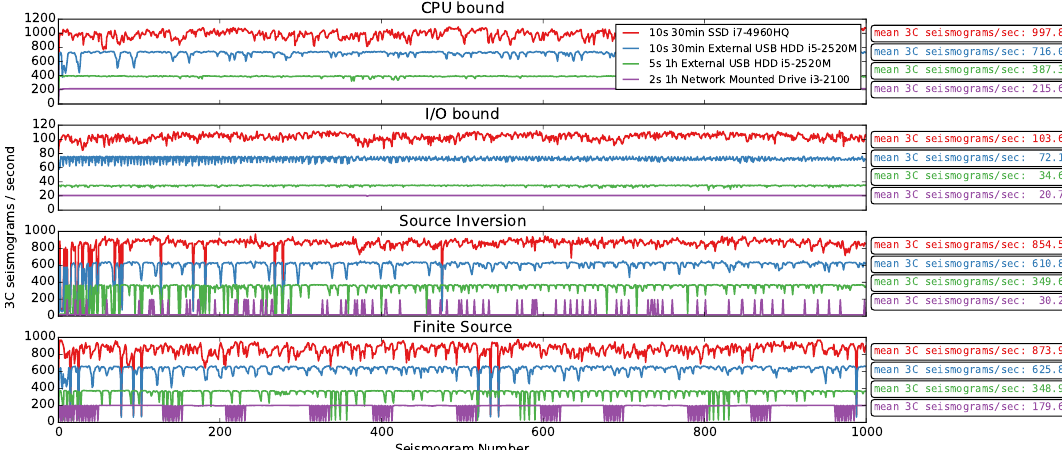
Figure 16. Results of benchmarks for four typical use cases run on different hardware with a variety of shortest periods. The graphs show the inverse time for the calculation of the i th three-component seismogram. Each run calculated 1000 three-component seismograms, is repeated 10 times with the same random seed, the top and bottom values are discarded, and the mean of the remaining eight values is plotted. The CPU and I/O bound scenarios illustrate the speed with a fully efficient and a deactivated cache, respectively. The two bottom scenarios emulate real use cases, see the main text for details. Amongst other things they show the consequence of a too small cache in the source inversion scenario for the 2s run and the efficiency of the buffer in the finite source scenario for the same database.